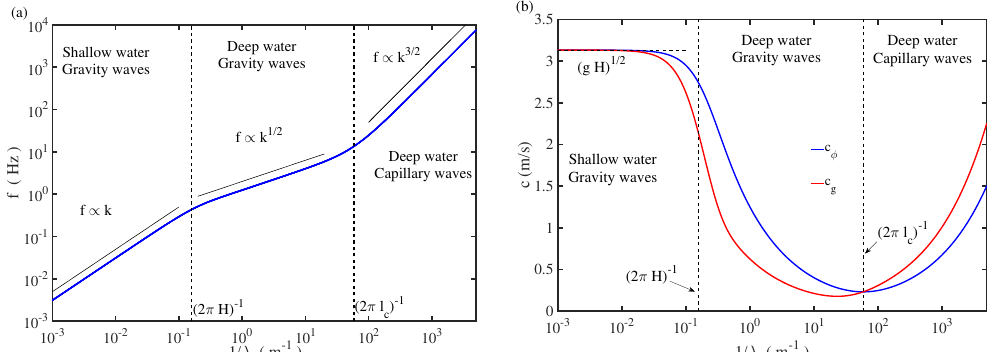
Figure 2. ( a ) Theoretical linear dispersion relation for surface waves expressed in a log–log diagram frequency f = ω / ( 2 π ) as a function of the inverse wavelength 1/ λ = k / ( 2 π ) . The curve is computed using Equation (19) for a depth H = 1m, a surface tension γ = 72 × 10 − 3 N m − 1 , and a density ρ = 1000 kg m − 3 . k H = 1/ H —separate shallow- and deep-water regimes. k c = 1/ l c —separate gravity and capillary wave regimes. ( b ) Blue phase velocity— c φ = ω / k , and red group velocity— c g = ∂ω / ∂ k , as a function of 1/ λ , according to the linear dispersion relation.